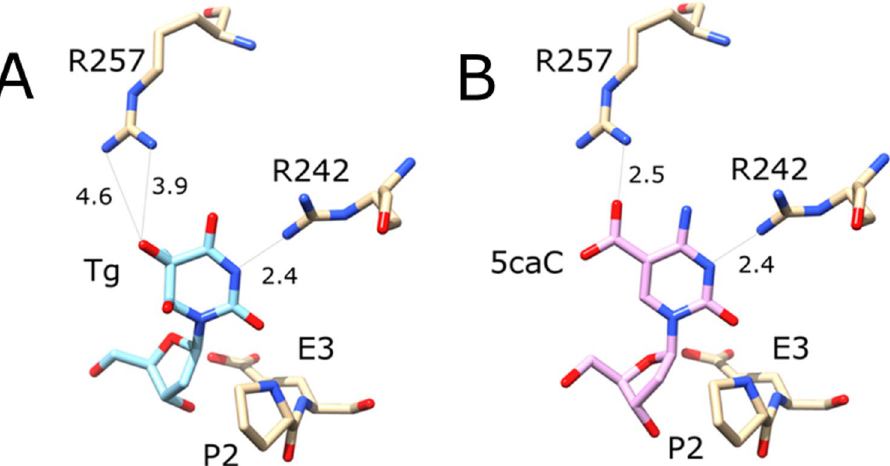
Figure 3. Structural plausibility of the NEIL1 glycosylase activity against DNA containing 5caC: ( A ) Composite model of the active site with flipped 2 ′ -deoxythymidine glycol. The figure was drawn based on the coordinates determined by Zhu and coworkers for the P2G variant (PDB accession 5ITY) 29 . The coordinates for the P2 residue in the wild-type were taken from the structure of NEIL1 with a THF abasic site analogue (PDB accession 5ITT) 29 . Distances in panel A are experimental distances for the molecule A in the structure 5ITY. Both arginine residues adopt different conformations in the other molecules of the asymmetric unit. Note that the pocket for the base is completely obliterated in the 5ITT structure with abasic site analogue. ( B ) Composite model of the active site with flipped 5caC 2 ′ -deoxynucleotide. The 5caC 2 ′ -deoxynucleotide was taken from the structure of TDG with DNA containing 5caC (PDB accession 3UO7) 53 , and placed based on least squares superposition of the (planar) 5caC base on the (non-planar) thymidine glycol base. Note that Tg has been reported to adopt a lactim tautomeric structure with hydrogen bond acceptor in the N3 position 29 . 5caC also has a hydrogen bond acceptor in this position, and is likely protonated in this position to support departure of the base, as suggested for TDG before 45 . The catalytic residues P2 and E3 are strictly conserved. The position of R242 is subject to RNA editing, making this residue either R or K 37 . R257 is conserved in many, but not all vertebrates. Numbers indicate distances in Å.